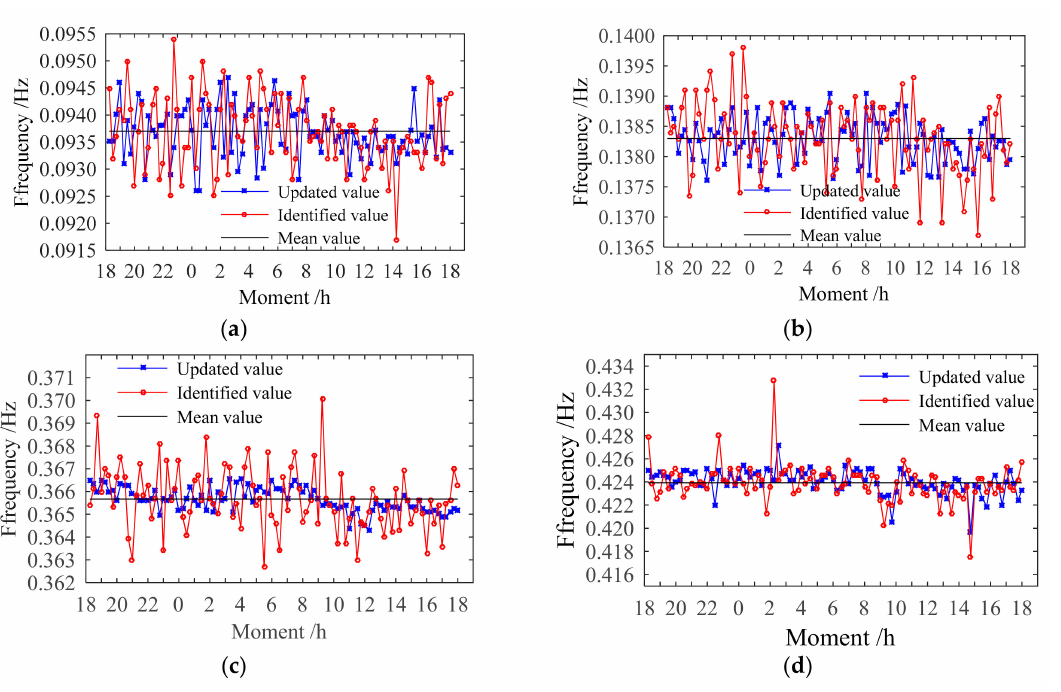
Figure 22. First 4 modal frequency changes after eliminating the influence of ambient factors: ( a ) First; ( b ) Second; ( c ) Third; ( d ) Fourth modal